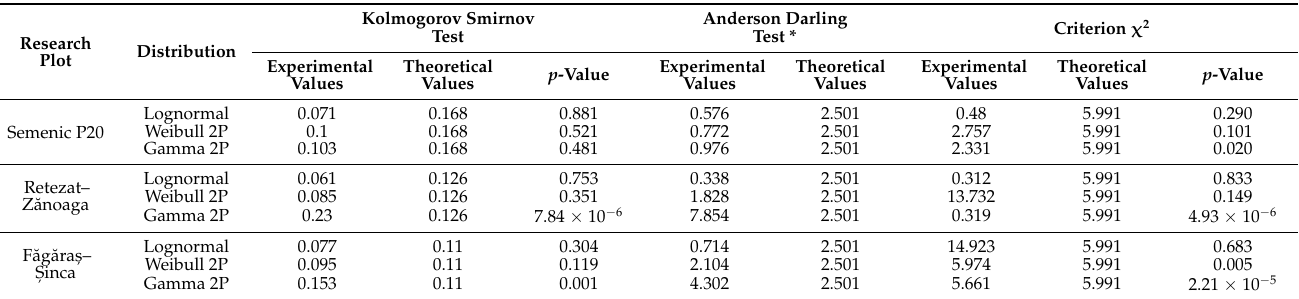
Table 5. Experimental values of volume of dead wood specific goodness of fit tests.